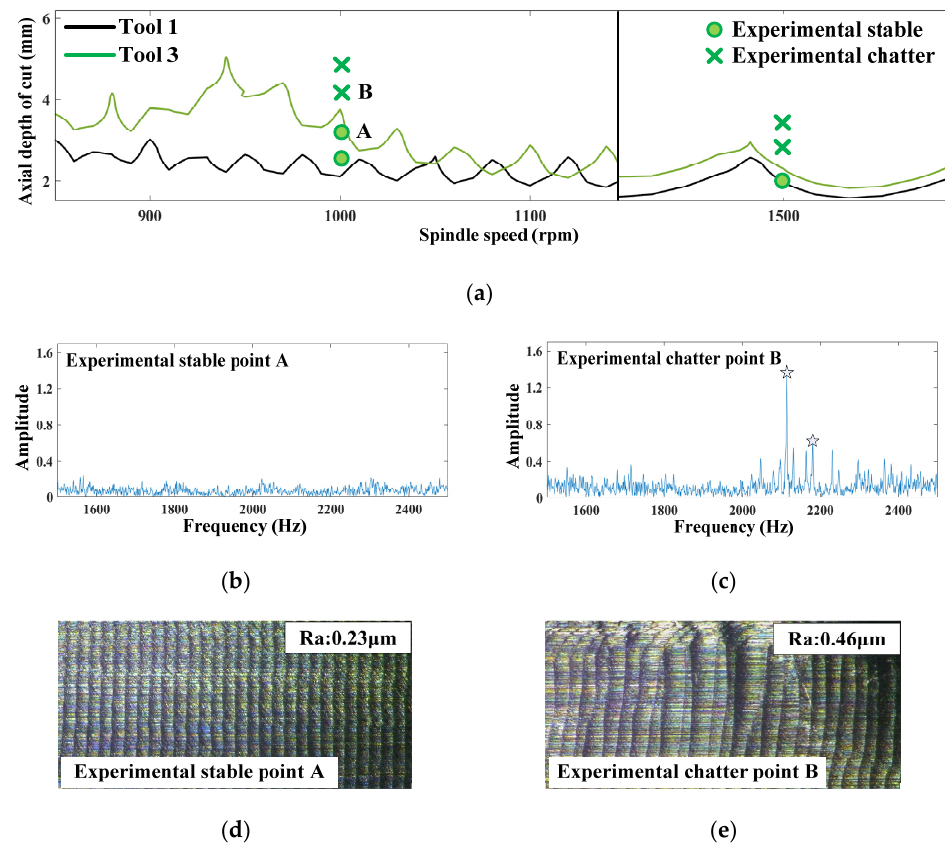
Figure 8. Experimental results of laboratory cases; ( a ) stability diagrams and experiment points; ( b ) FFT spectrum of experiment point A; ( c ) FFT spectrum of experiment point B; ( d ) machined surface topography of experiment point A; ( e ) machined surface topography of experiment point B.